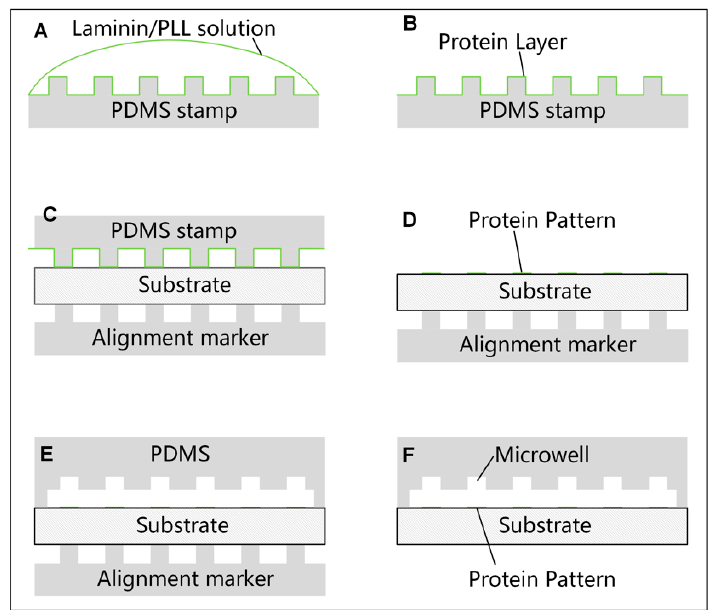
Figure 2. Fabrication of the of the microfluidic device with paired microwells and protein patterns. Schematics were not drawn to scale. ( A , B ) Stamp incubation with the protein solution; ( C , D ) Printing protein patterns on the substrate; ( E , F ) Protein patterns and microwells pairing with the help of a polydimethylsiloxane (PDMS) alignment marker.